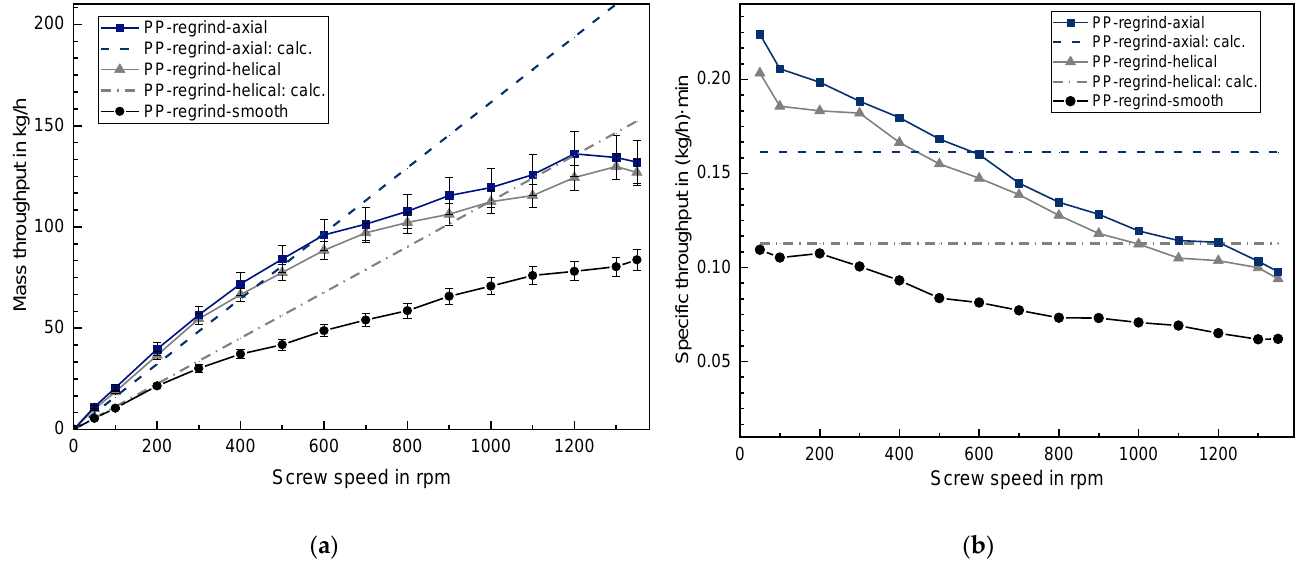
Figure 9. ( a ) Mass throughput and ( b ) specific mass throughput for the regrind PP material.